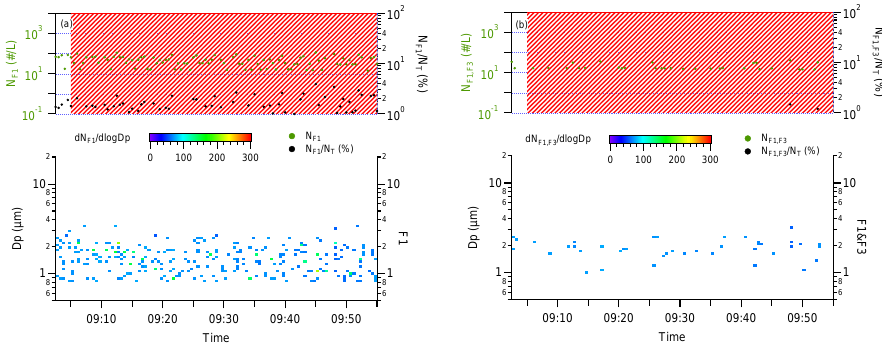
Fig. 5. WIBS-4 fluorescence data for ammonium sulphate–CAST soot aerosol mixture experiment conducted during BIO-05. The data are plotted in the same way as in Fig. 3. Pre-experimental period illustrated by a colorless area, while ammonium sulphate–CAST soot aerosol mixture is represented by a red shaded area.